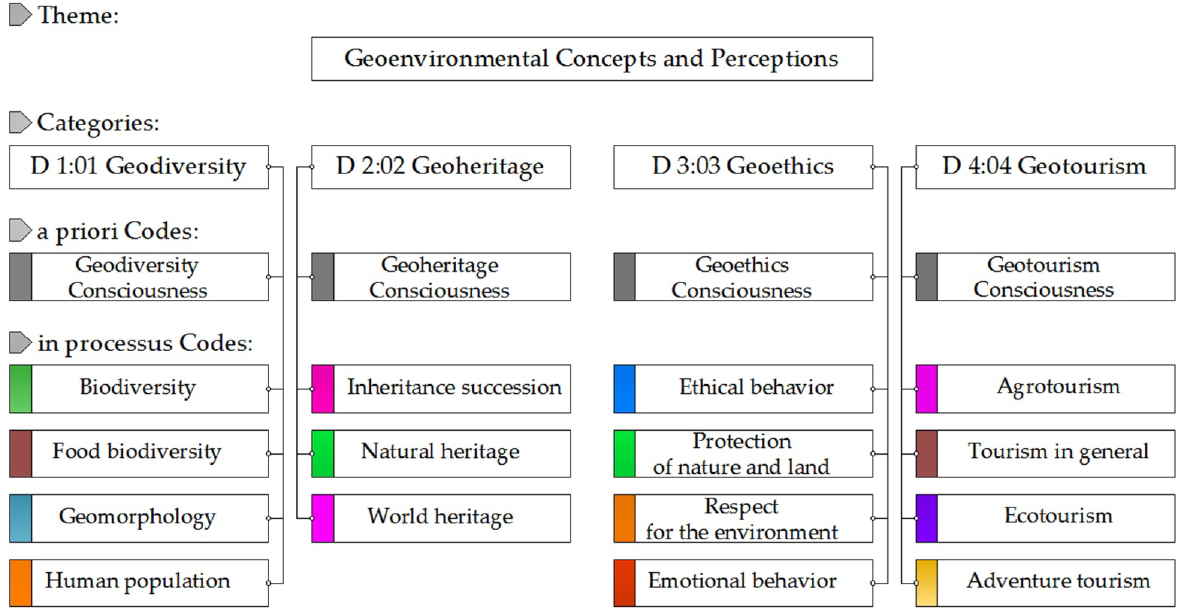
Figure 3. Thematic map: theme, categories, codes and coding color index.